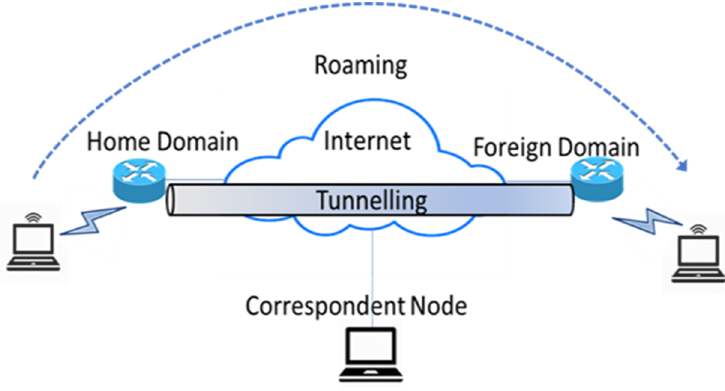
Figure 2. Mobile IPv4 .